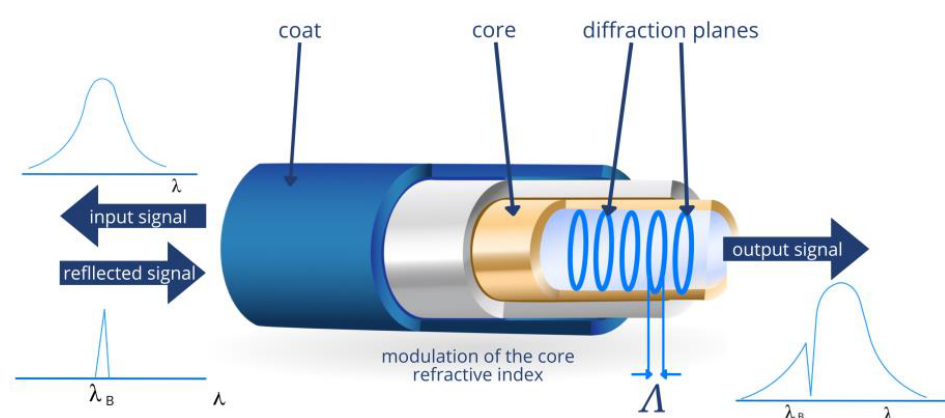
Figure 9. Optical Bragg grating structure